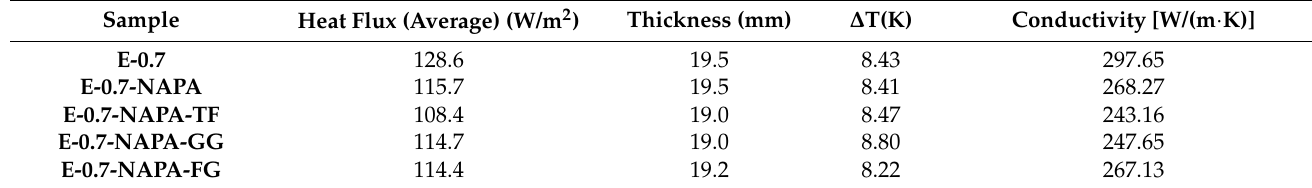
Table 8. Heat flux meter measured